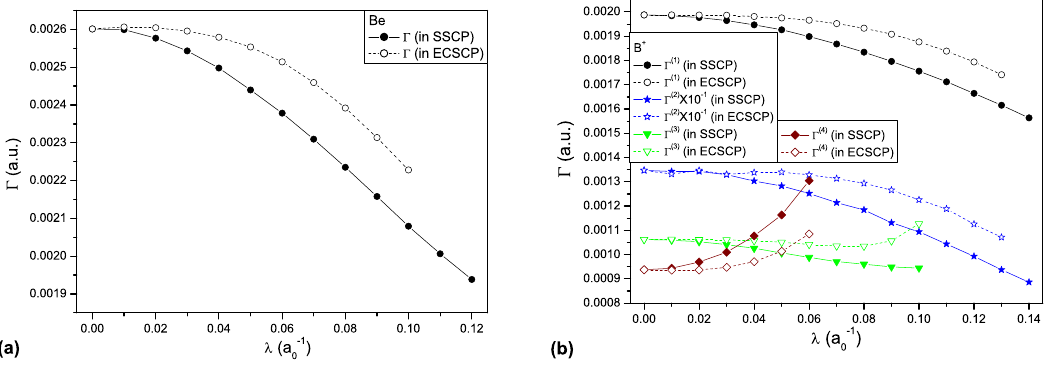
Figure 4. ( a ) Resonance widths ( Γ ) corresponding to the resonance energies in Figure 3. ( a ) Be, ( b ) B +